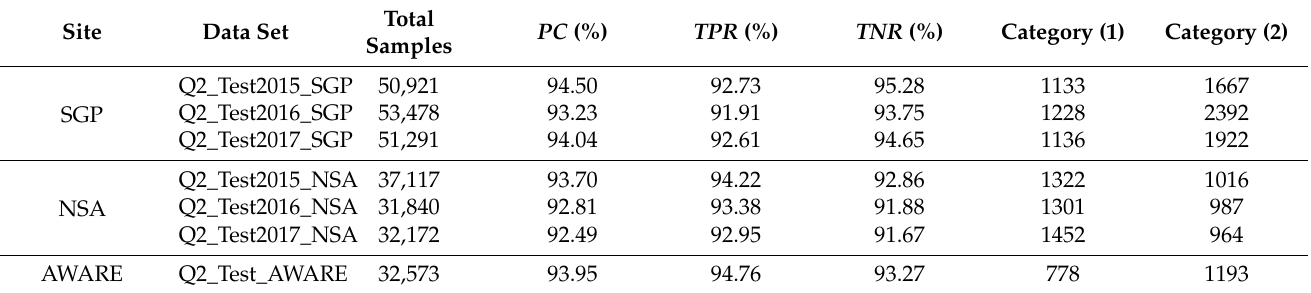
Table 6. The classification results of testing set based on the proposed algorithm.